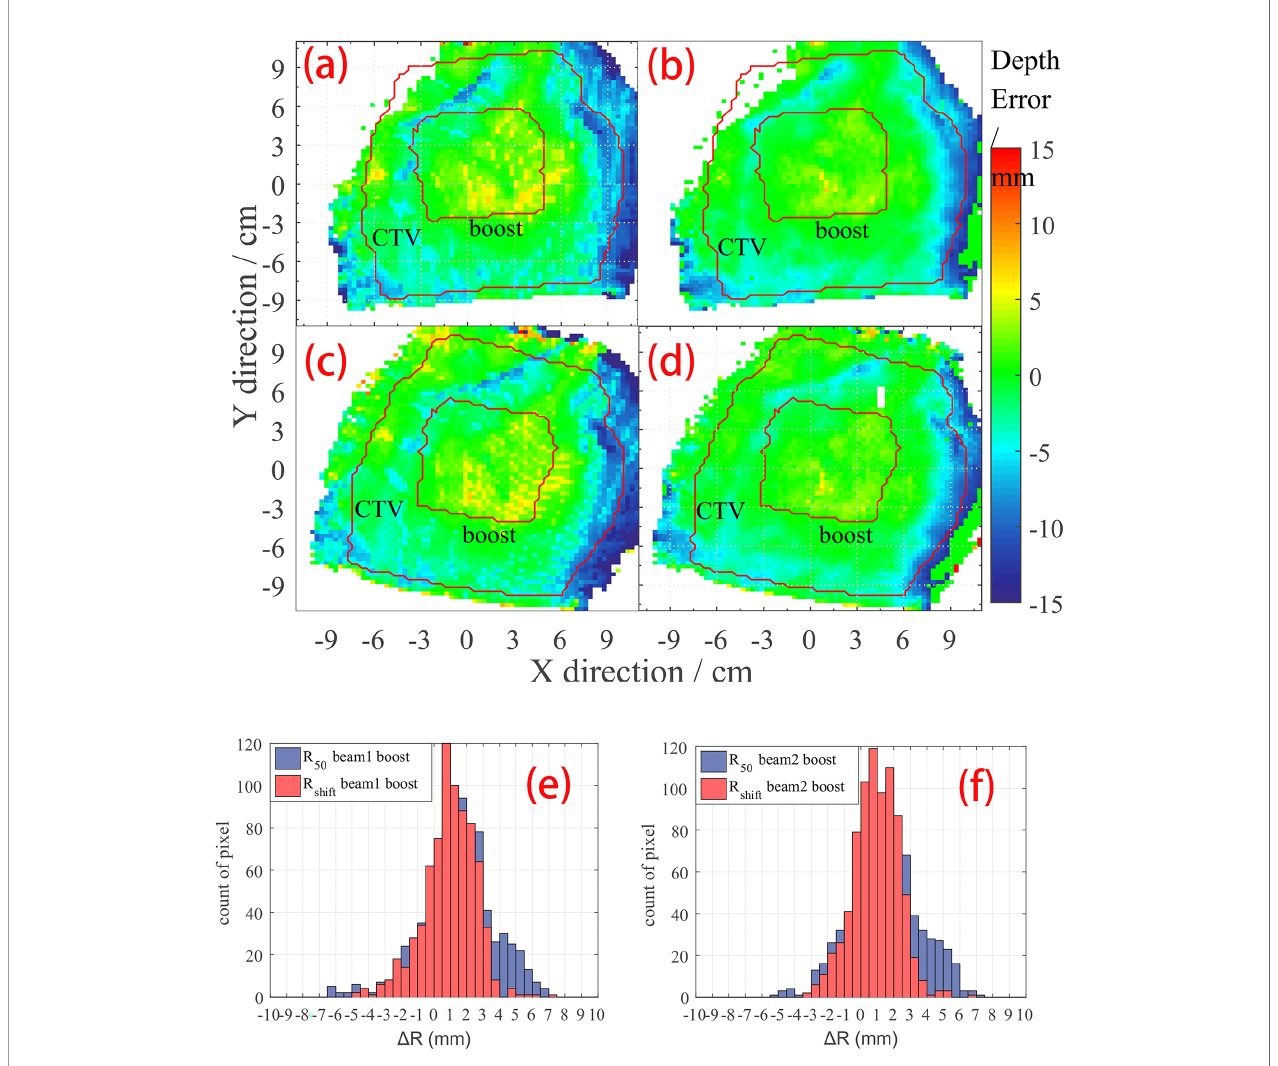
FIGURE 5 | D R detail result of case no. 10. The CTV and boost areas are marked within the red curve. (A) R 50 depth error map on beam 1; (B) R shift depth error map on beam 1; (C) R 50 depth error map on beam 2; (D) R shift depth error map on beam 2. Histogram of depth error statistic on boost region on (E) beam 1 view, and (F) beam 2 view of case no.